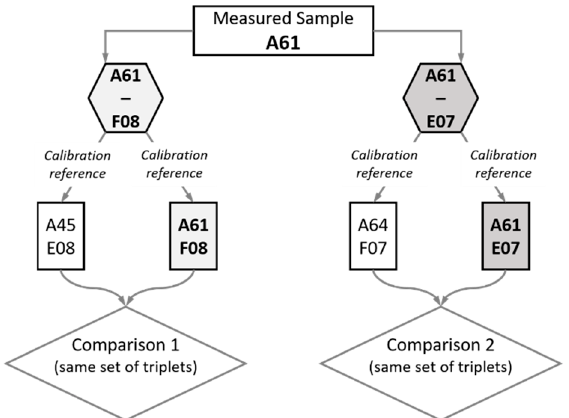
Figure 6. Representative diagram explaining the experimental steps followed in the two-comparison study. The patterns F08 and E07 were selected for this study on the measured sample A61. Measurements of capacitances maps on these two patterns were performed. However, for comparison 1, the SMM has been calibrated using two different reference structures: first A45E08 and then A61F08 itself. These two calibrations were made using the same set of numbered capacitor triplets on each reference structure. A similar workflow has been conducted on the A61 E07 structure, as shown.